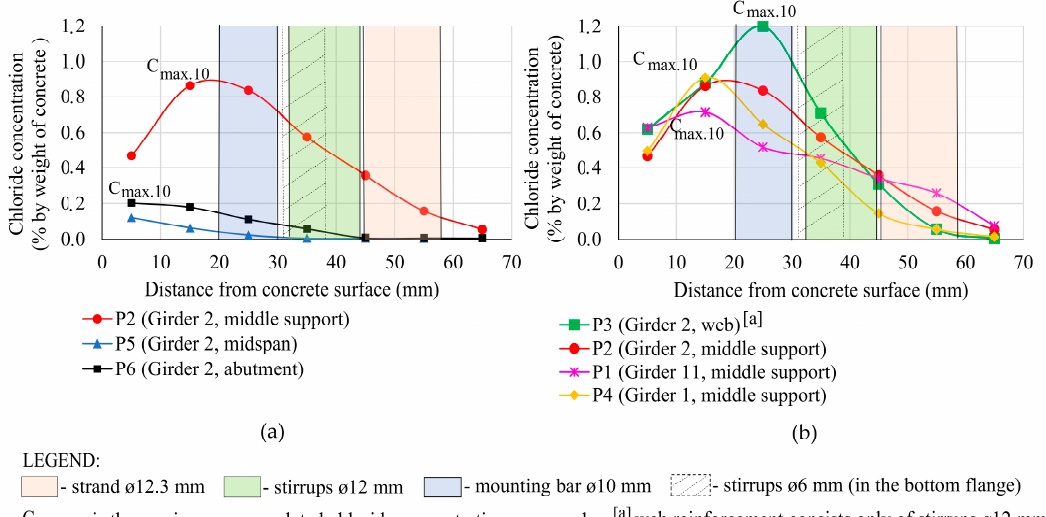
Figure 10. Chloride profiles obtained in Girders 1, 2, and 11: ( a ) along the bottom flange in Girder 2; ( b ) near the middle support in Girders 1, 2 and 11.